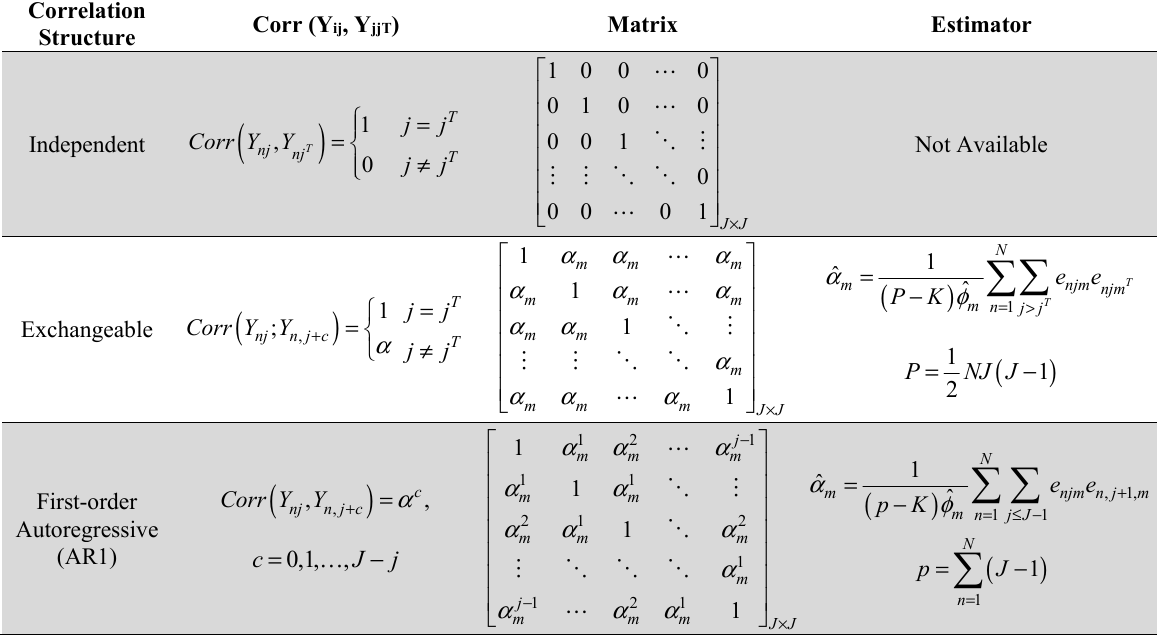
The working correlation matrix structure.